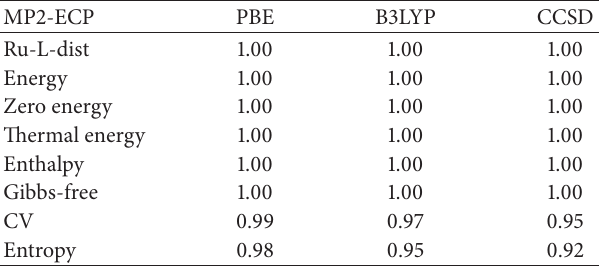
Table 4: The RMSD of the optimized geometries obtained from other methods of computation from that obtained from MP2 using SBKJC VDZ ECP basis